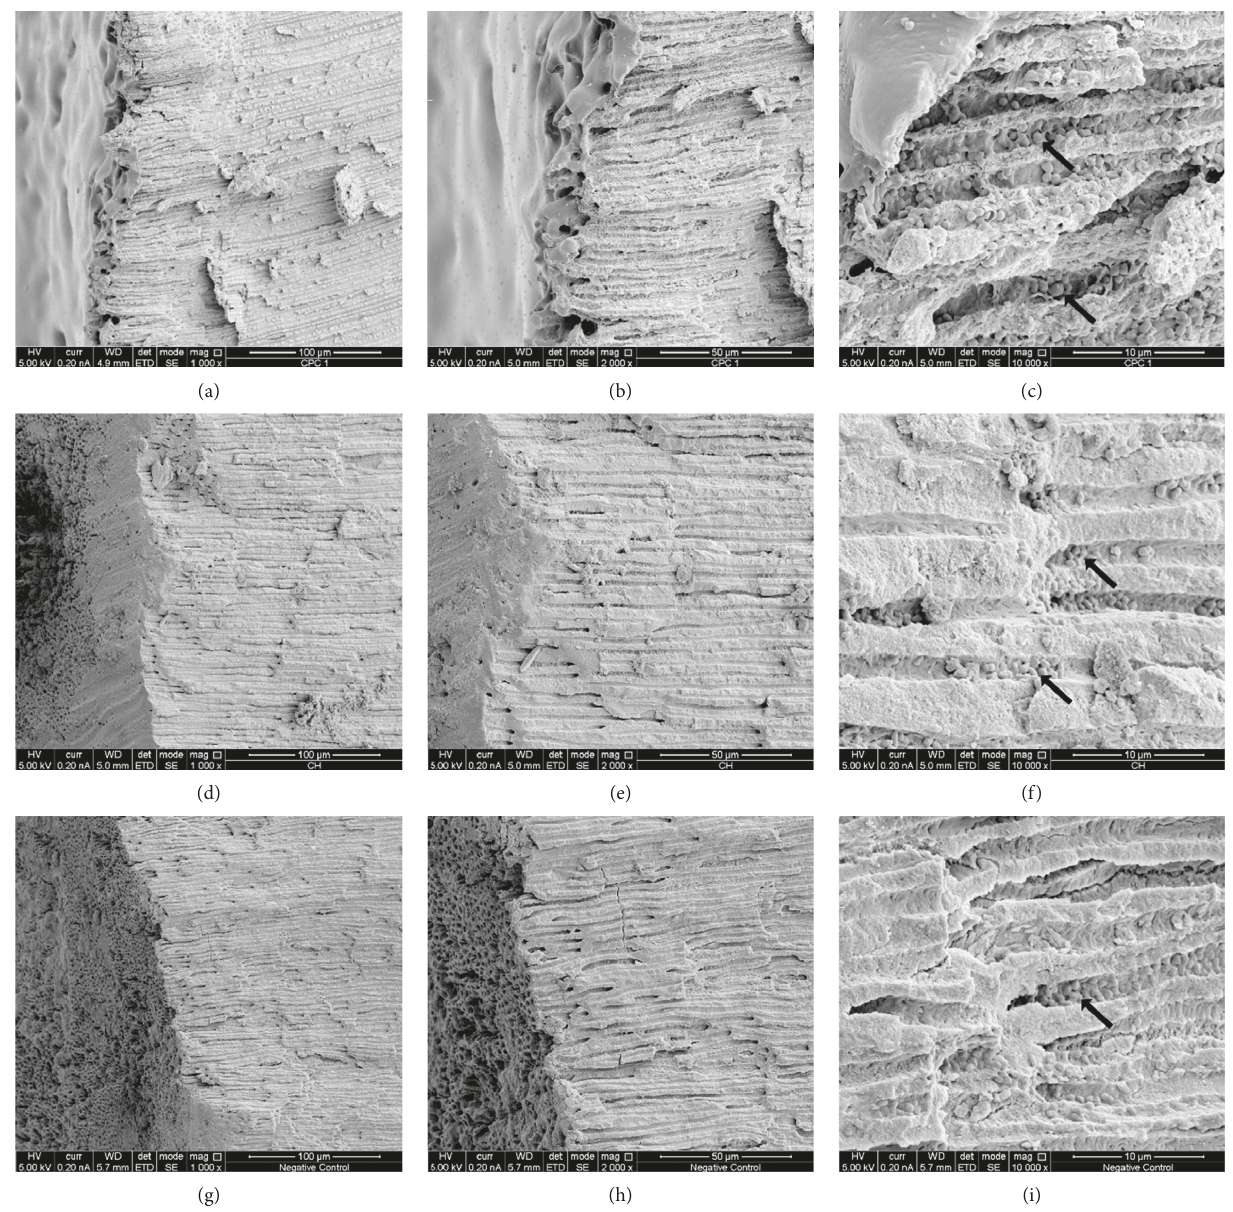
Figure 4: SEM images of dental specimens after intracanal treatment. SRF-CPC sample at 1000x (a), 2000x (b), and 10000x (c). CH sample at 1000x (d), 2000x (e), and 10000x (f). Negative control sample at 1000x (g), 2000x (h), and 10000x (i). Black arrows point at bacterial cells inside dentinal